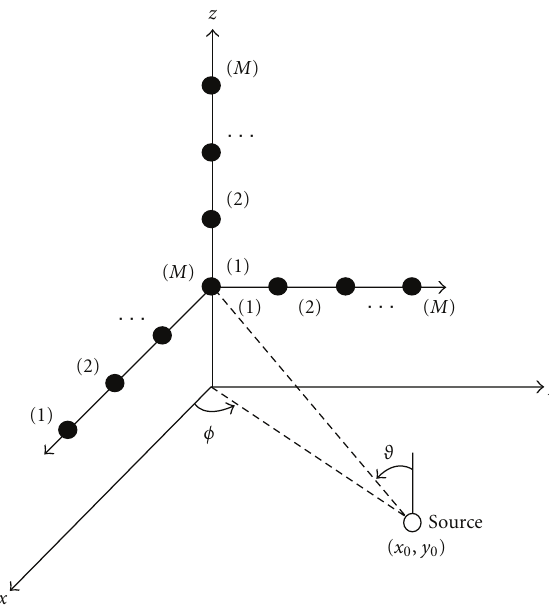
Figure 5: 3D L-shaped array